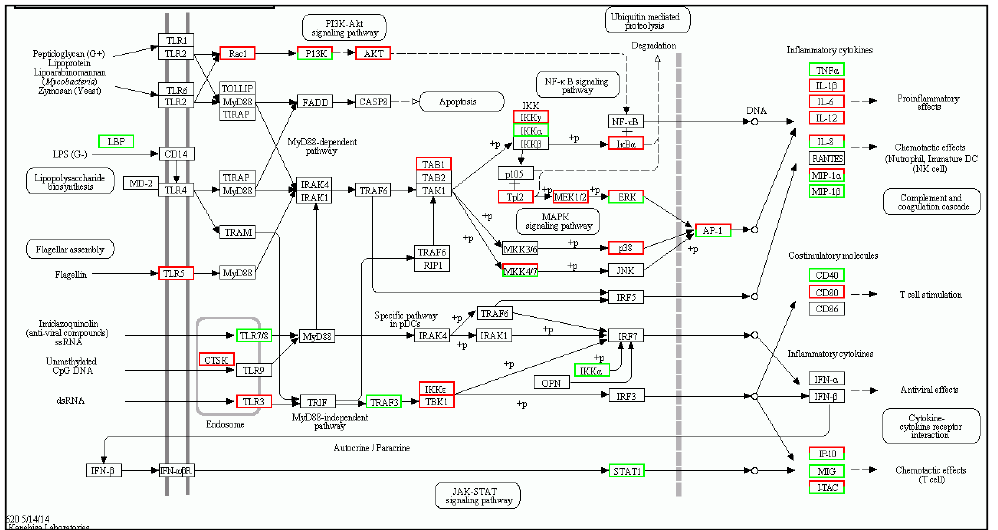
Figure 4. Toll-like receptor signaling mapping in spleen by KEGG. Red boxes indicate significantly differentially up-regulated expression and white boxes indicate unchanged expression in the transcriptomic profile.